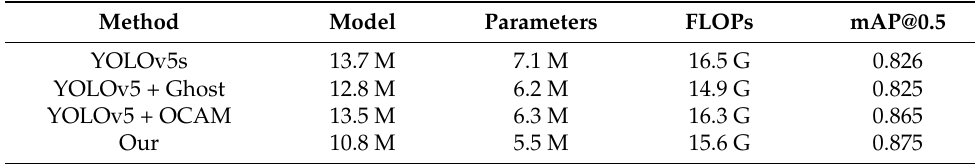
Table 4. Ablation experiments.